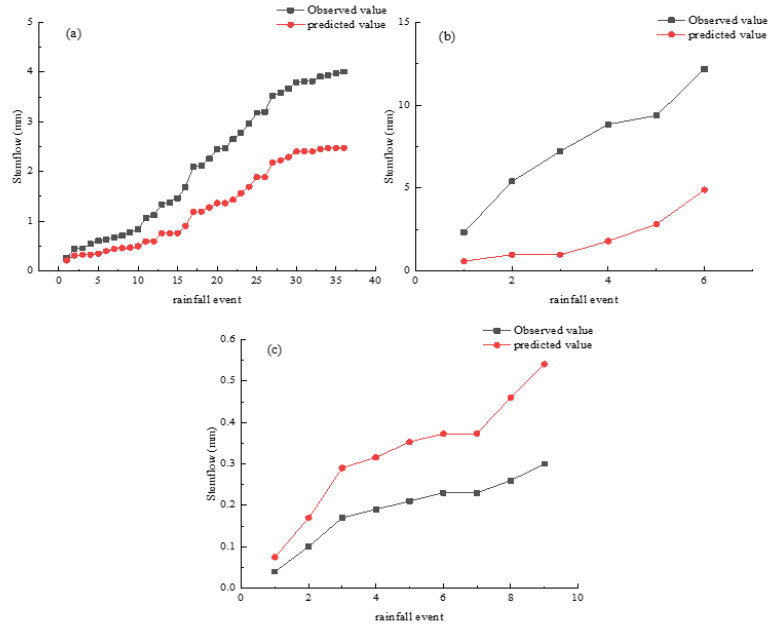
Figure 8. Comparison of cumulative observed and predicted stemflow. ( a ): Rainfall pattern A; ( b ): rainfall pattern B; ( c ): rainfall pattern C.